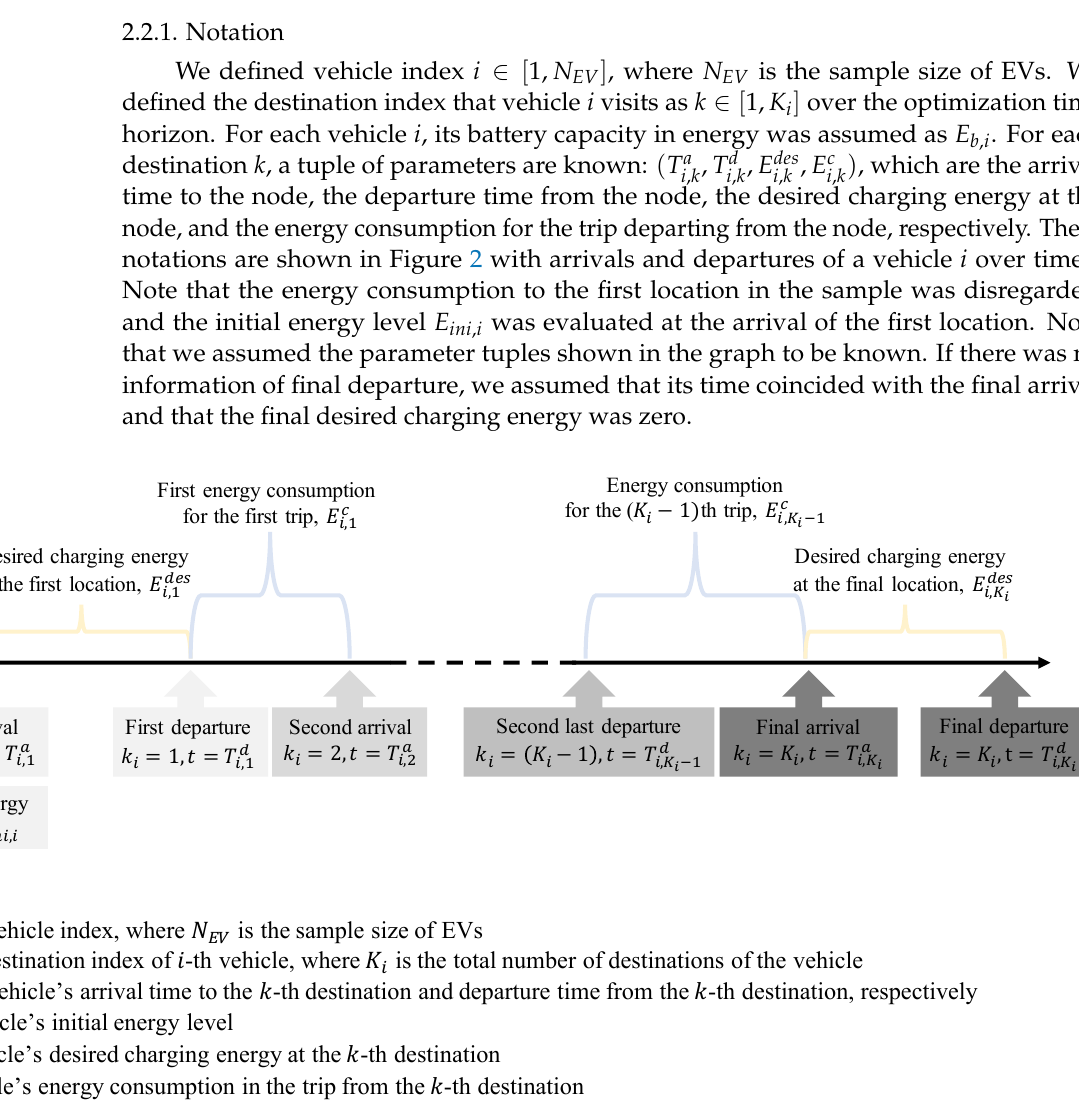
Figure 2. Notations to describe the multiple destinations for a